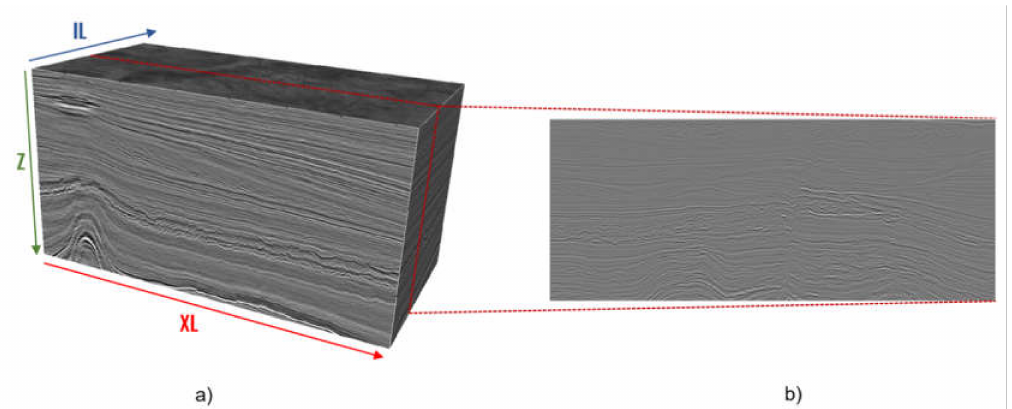
Figure 1. ( a ) Seismic Volume, ( b ) Slice (cut on the seismic volume) on a fixed IL